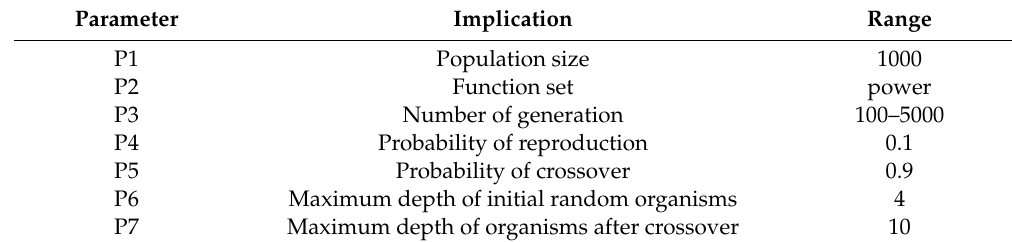
Figure 15. Architecture of the BP artificial neural network. Table 3. Parameters of the GA-BP model.